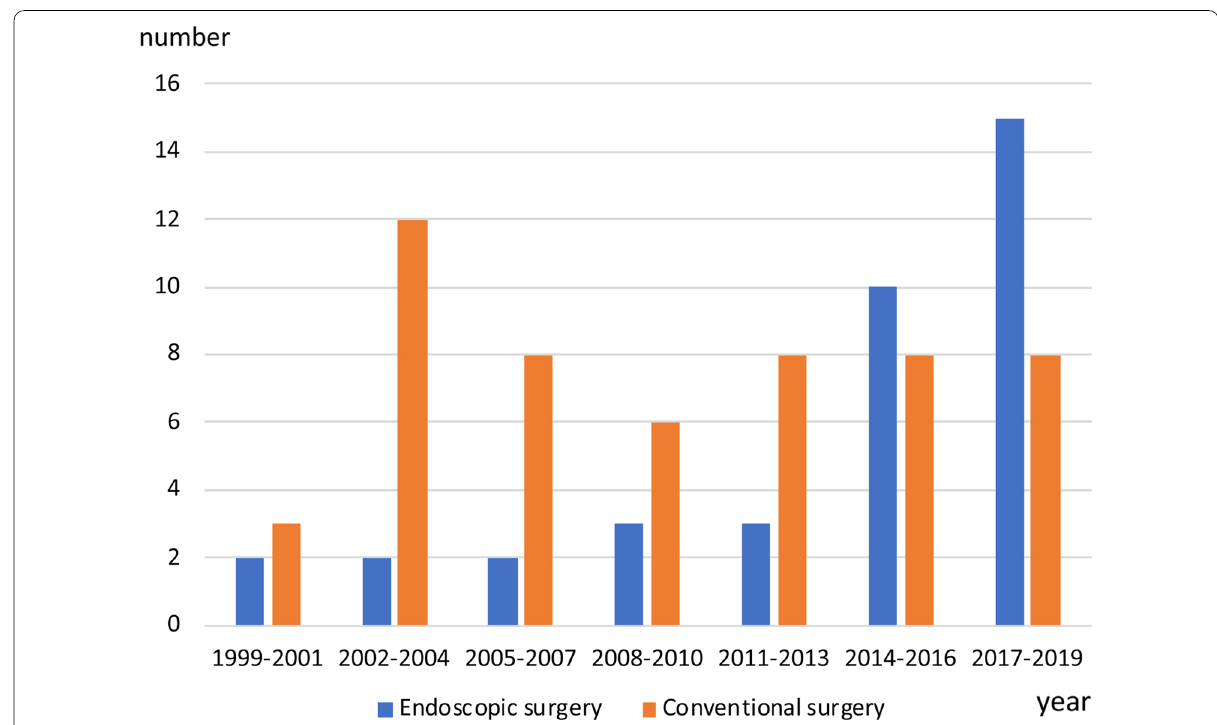
Fig. 3 Trends in the numbers of surgeries for adult Bochdalek hernia from 1999 to 2019 grouped by operative method (endoscopic versus conventional